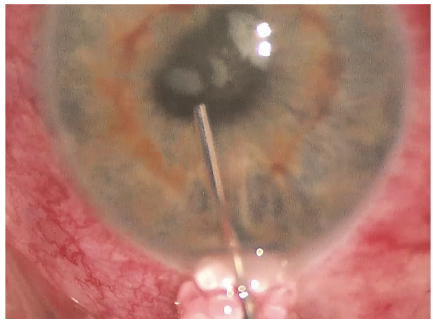
Figure 1: Total posterior synechia with seclusion pupillae and fundus obscuring cataract.